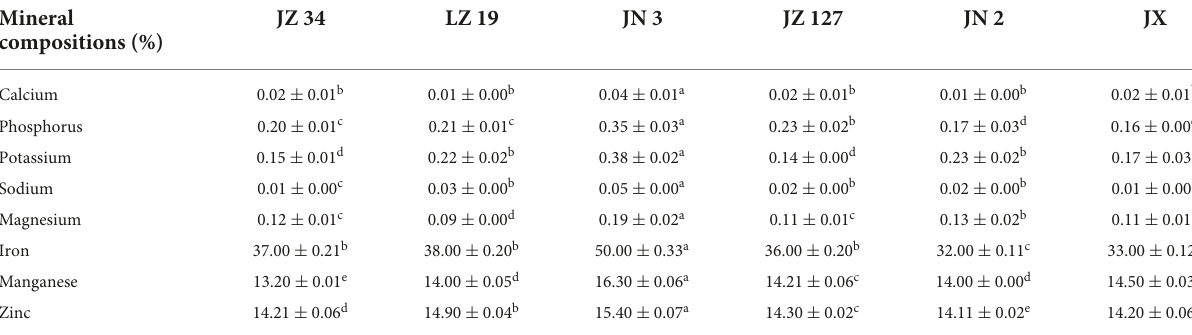
TABLE 5 Mineral compositions of different sorghum grains.